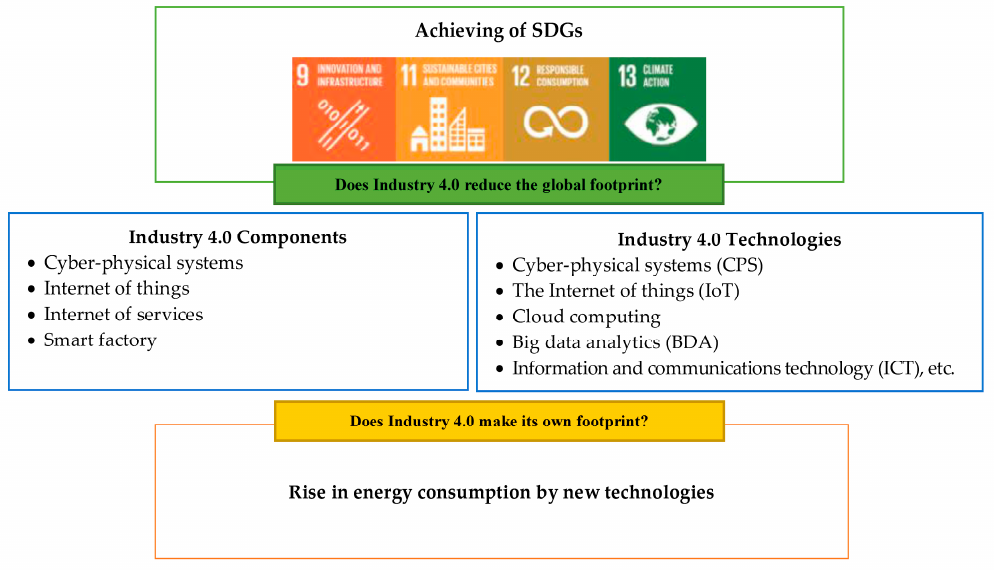
Figure 3. Concept of Industry 4.0 and sustainability implications. Source: Compiled by author.